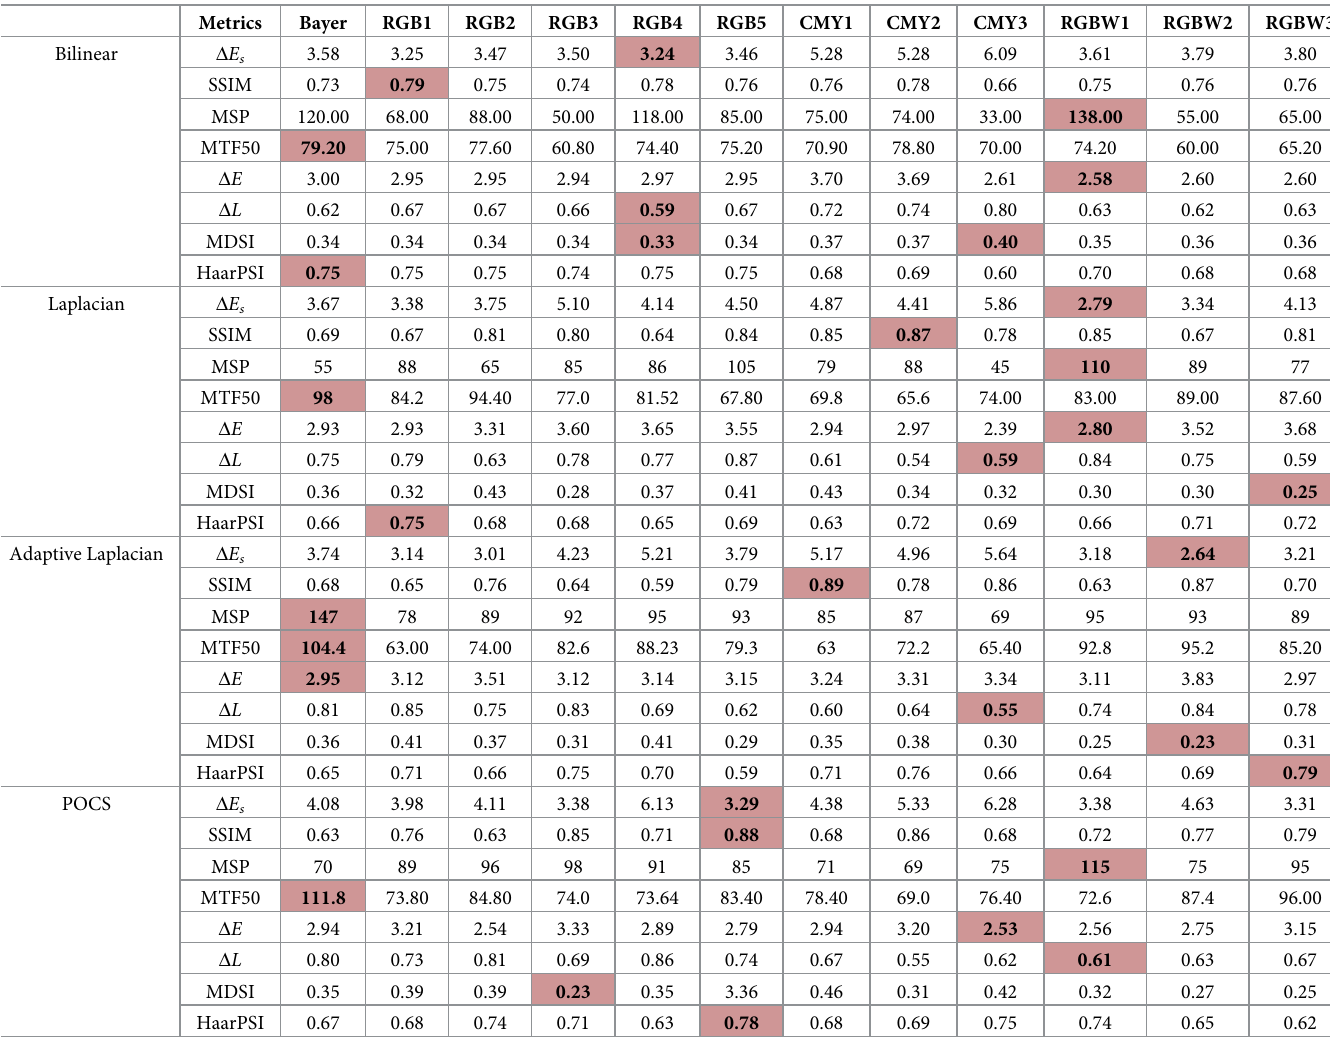
Table 2. Comparison results of all metrics for test CFAs according to demosaicing methods. Metrics